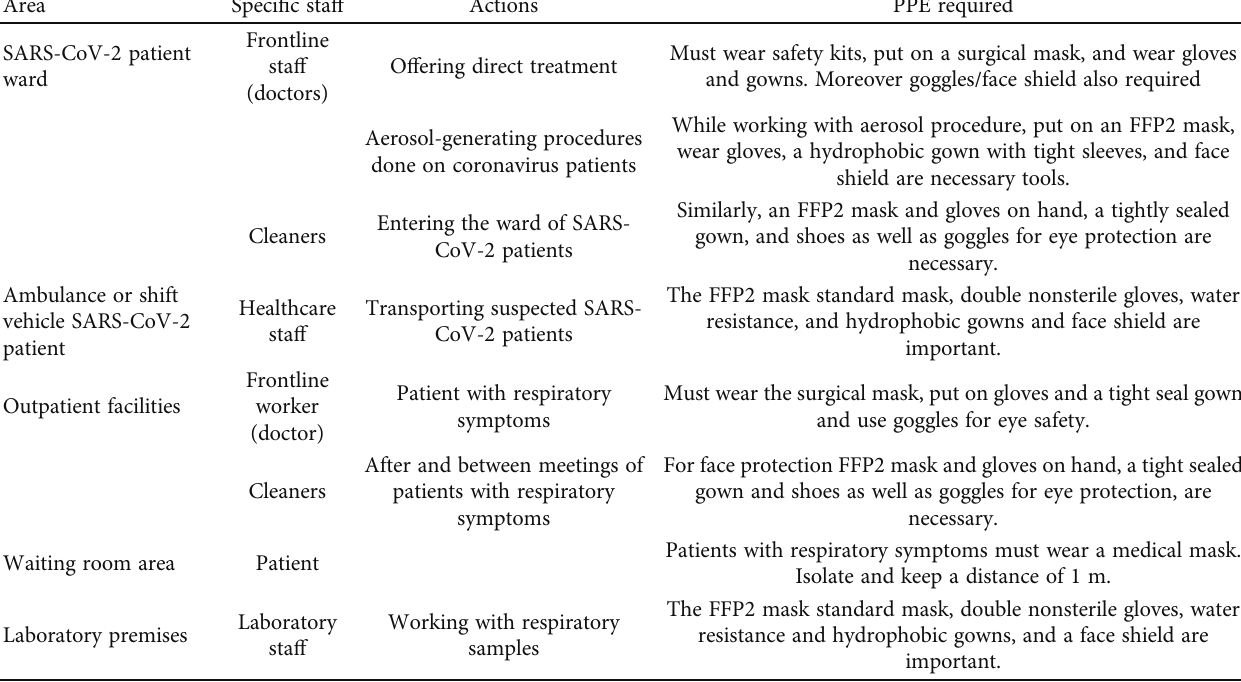
Table 2: Proposed type of PPEs in the context of SARS-CoV-2 infection [104].